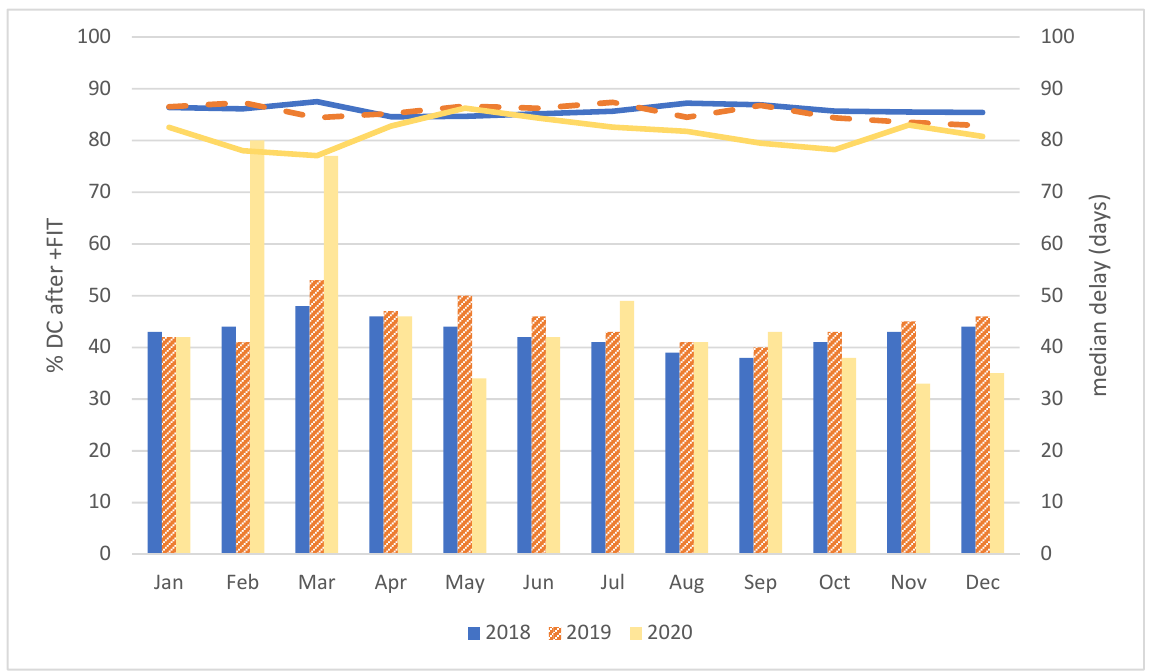
Figure 1. Overview of DC compliance and the median delay after a positive FIT, by year and month of the FIT. In Figure 1: lines represent the DC compliance (in %); bars represent the monthly median delay (in days).